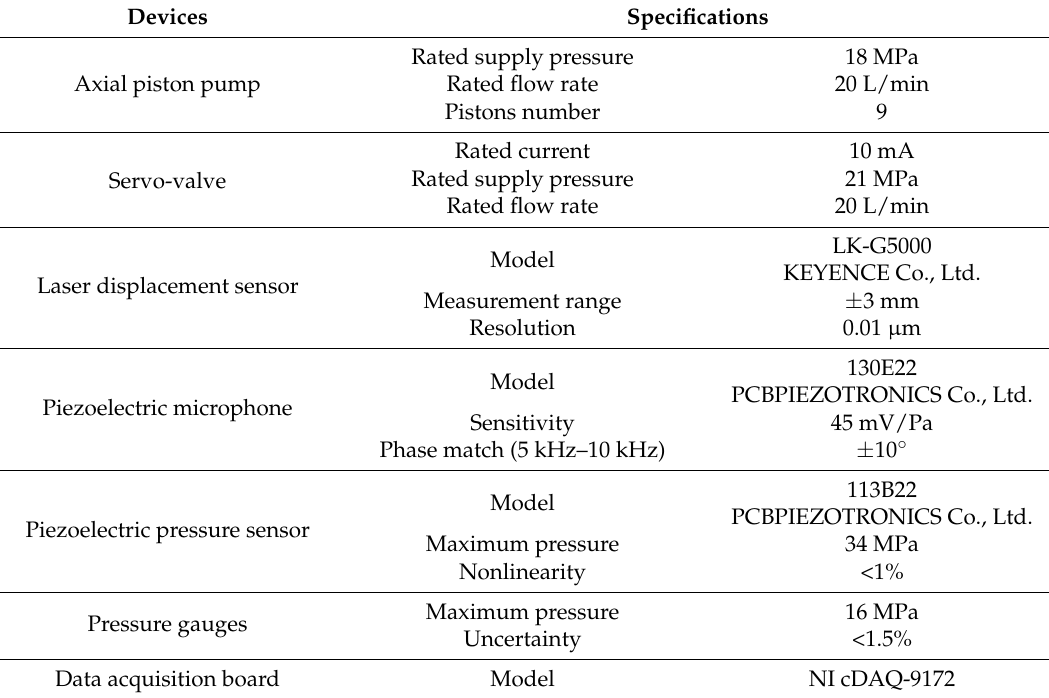
Table 4. Detailed specifications and probable uncertainties in measuring